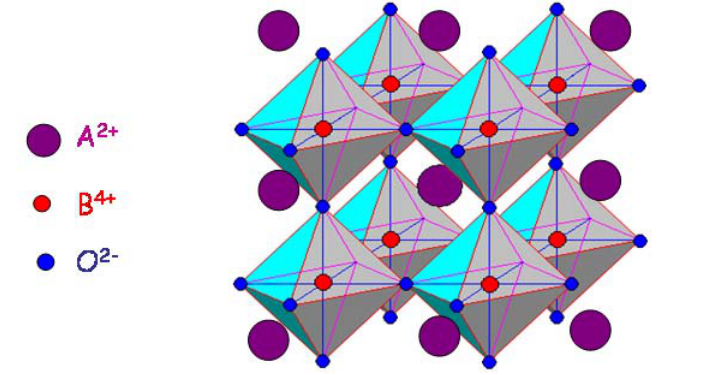
Figure 1. Perovskite structure made of two sublattices: 3-dimensional network of corner octahedra and cubic A 2+ linked BO 6